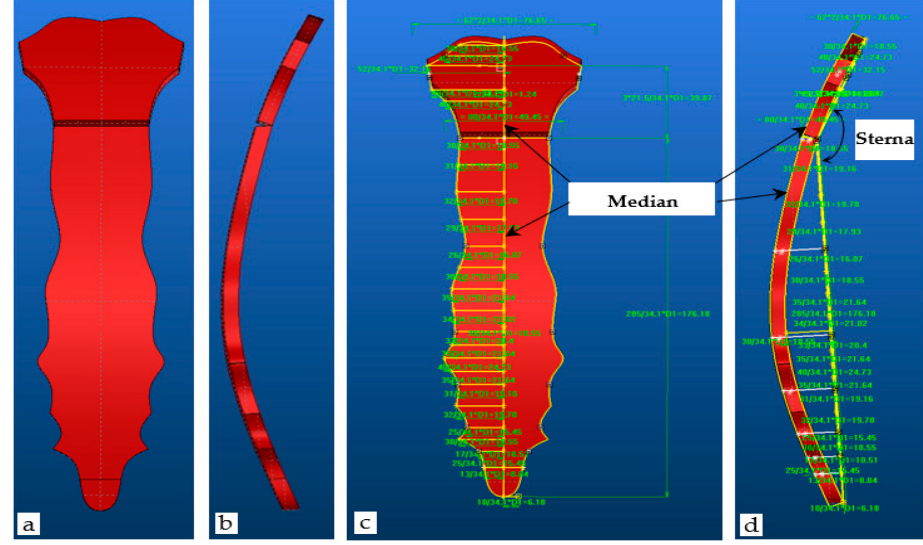
Figure 8. The ( a , c ) anterior view, and ( b , d ) left lateral view of the adaptive